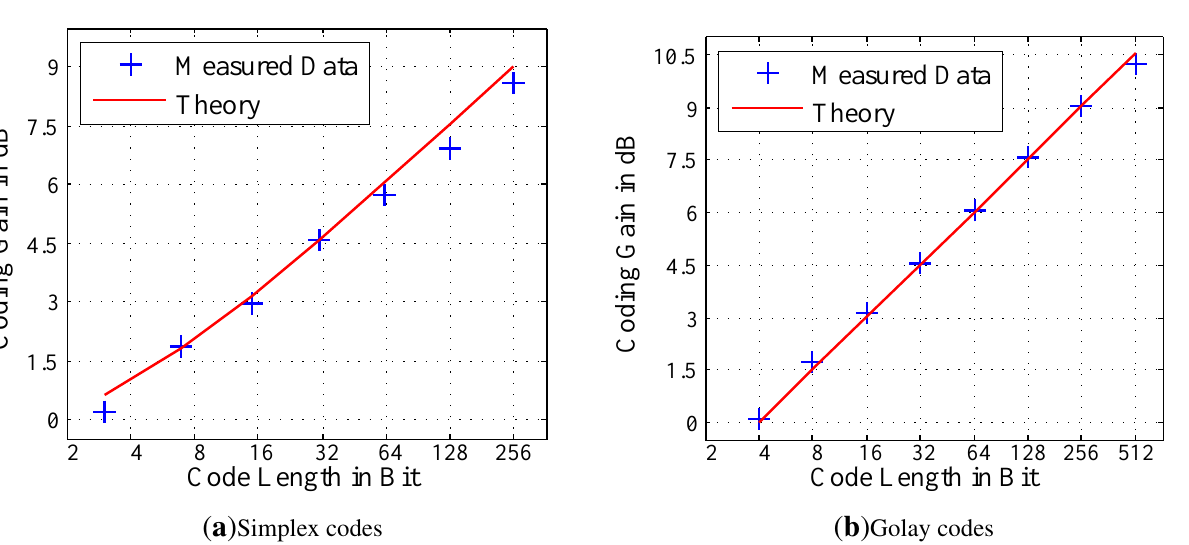
Figure 7. Comparison of theoretical SNR gain versus experimental SNR gain of ( a ) Simplex and ( b ) Golay Codes depending on the code